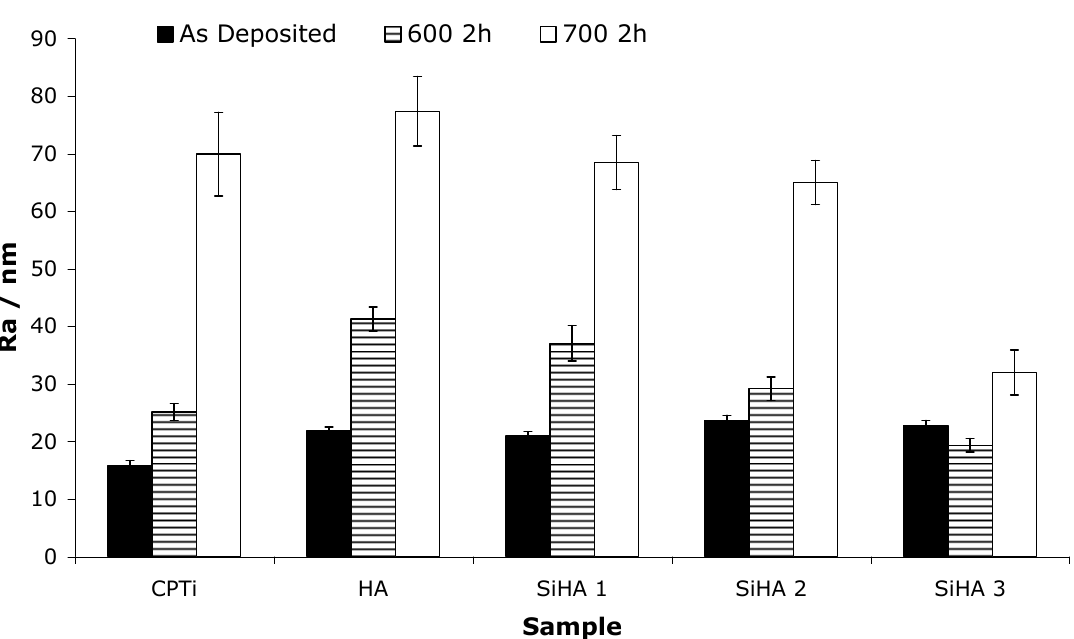
Figure 8. R a roughness values for CPTi, HA and SiHA thin films as received and heat treated at 600 and 700 °C in flowing argon for 2 h.